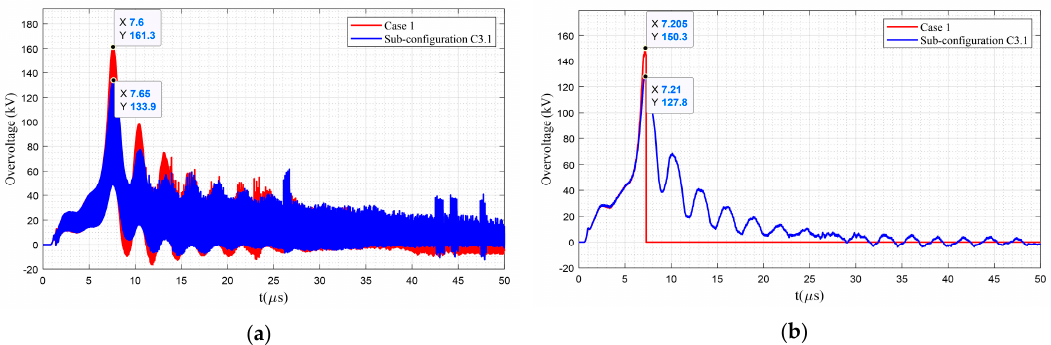
Figure 22. Overvoltage at terminal c of the transformer mounted on ( a ) pole #31, and ( b ) pole #36; Network with dry poles and direct lightning applied on pole #34.